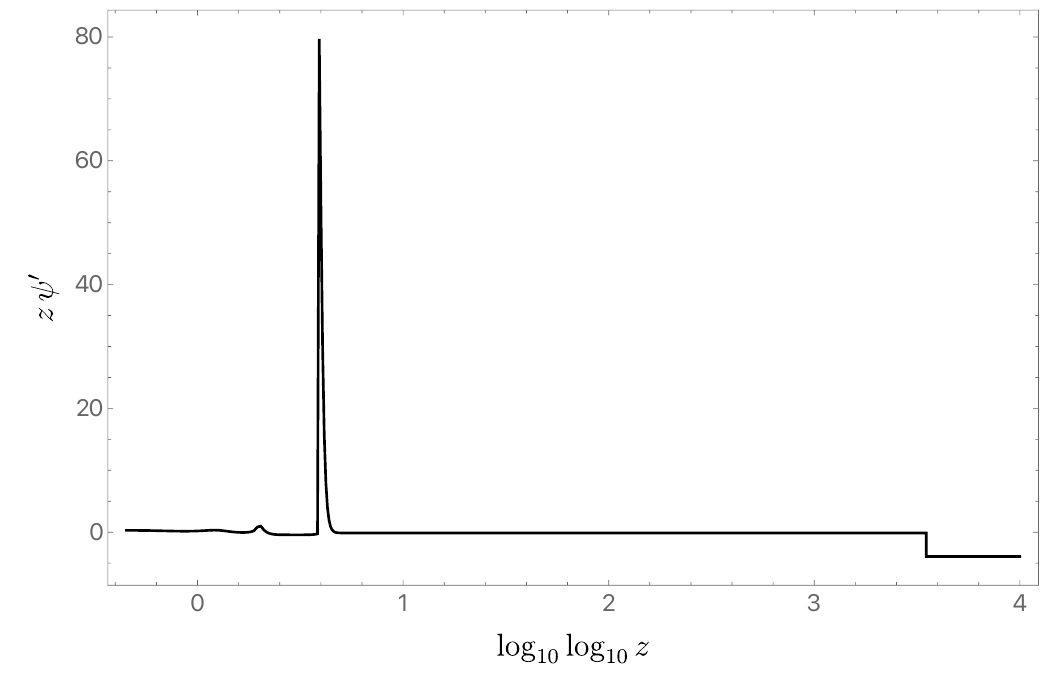
Figure 8 . Example of multiple Kasner transitions which occur when the first transition yields √ | β new | < 1 / 2 . For α = 1 , q = 0 . 5 m, mM = 0 . 5 and Q/Q c − 1 = 2 . 361775850 × 10 − 3 , the system starts with β = − 0 . 426086 , and it has β new = − 0 . 126666 after the first transition which triggers a second transition at a very large z of z ∼ 3 . 3017 × 10 3507 (note the double logarithmic scale) tr(2) that produces β = − 3 . 93114 new(2)